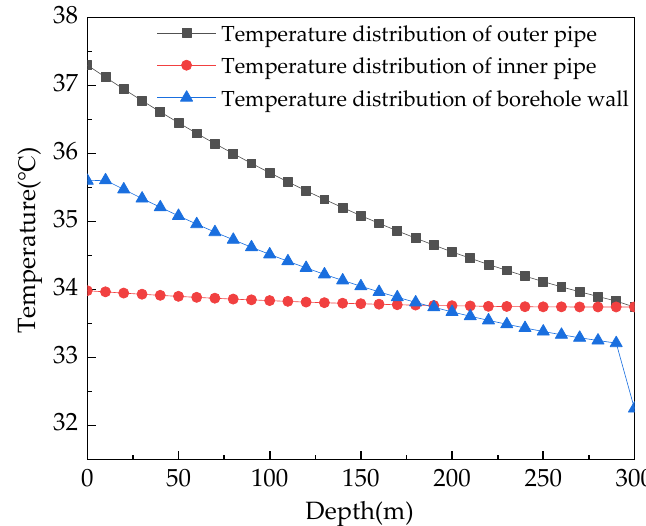
Figure 10. Temperature distribution in summer.